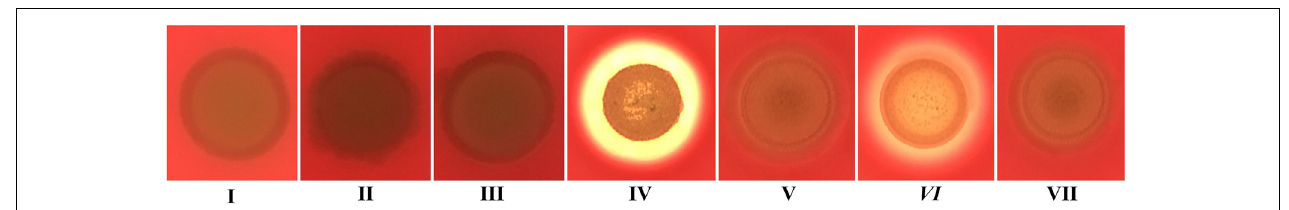
FIGURE 1 | Hemolytic activity of different Vibrio cholerae strains on LB-5% sheep blood agar. After being incubated at 37 ◦ C for 48 h, the LB blood plates were photographed. I, II, III, IV, V, VI, and VII represent WT/pBAD24, (cid:49) hlyU /pBAD24, (cid:49) hlyU /pBAD24- hlyU , (cid:49) hapR /pBAD24, (cid:49) hapR /pBAD24- hapR , (cid:49) fur /pBAD24, and (cid:49) fur/ pBAD24- fur ,